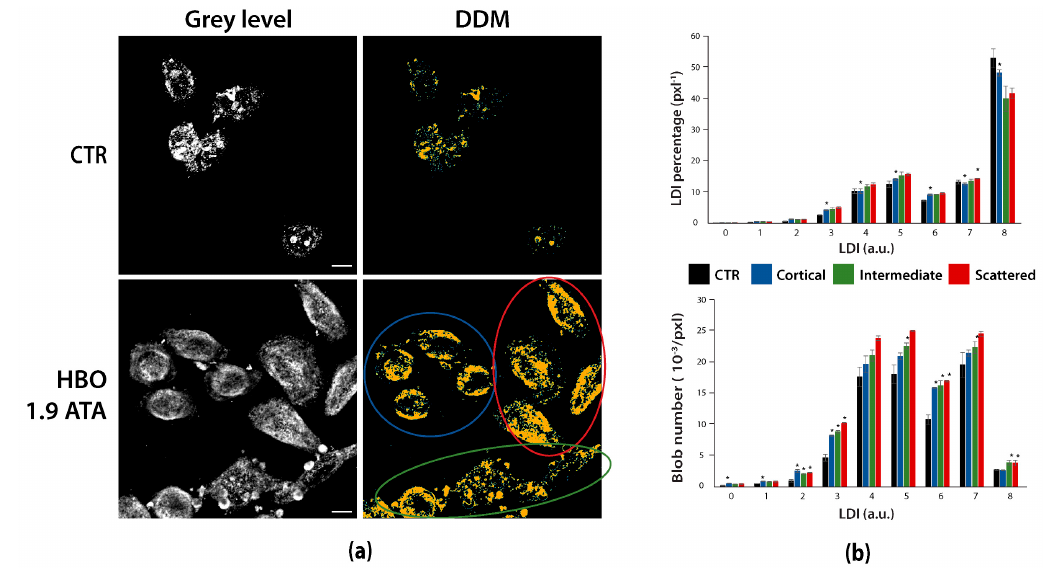
Figure 6. DDMs can detect and quantify sample heterogeneity. ( a ) Grey level images and DDMs of untreated (CTR) and 1.9 ATA HBO-treated HeLa cells marked against RNA:DNA hybrids. DDMs separate three cell groups of cortical (blue), scattered (red) and intermediate (green) hybrids distributions among HBO-treated cells. ( b ) Bar graphs of LDI percentages and derived blob number in HeLa cells. * p < 0.05 for statistical comparison of the three groups with the untreated control. Scale bars: 10 µm.